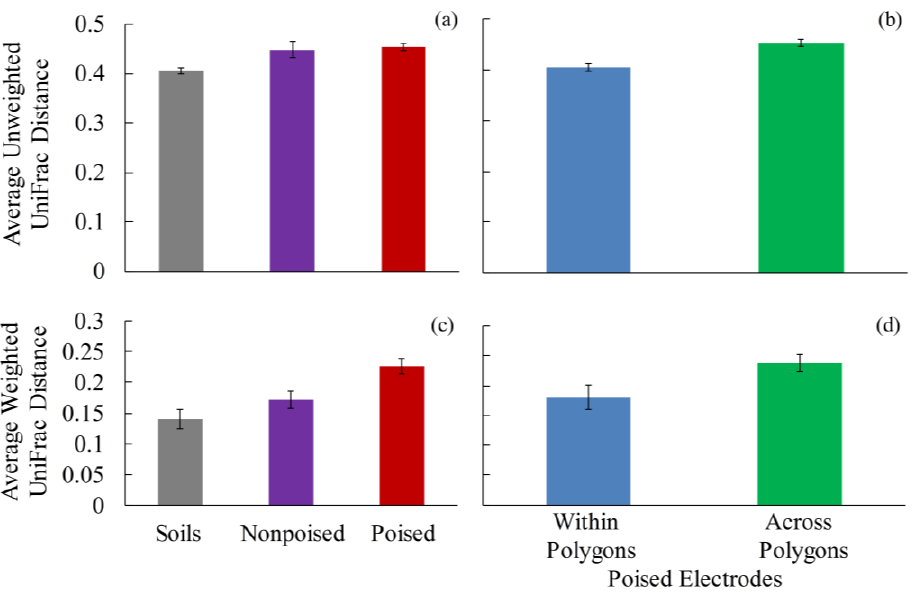
Figure 6. Average unweighted ( a , b ) and weighted ( c , d ) UniFrac distances between samples of different types. Microbial communities in soil samples from different polygons were more similar than communities from nonpoised and poised electrodes using both unweighted (one-way ANOVA, p = 0.06) and weighted UniFrac (one-way ANOVA, p = 0.008) distances ( a , c ). Additionally, microbial communities from poised electrodes within the same polygon were more similar than communities from poised electrodes in the other polygons using both